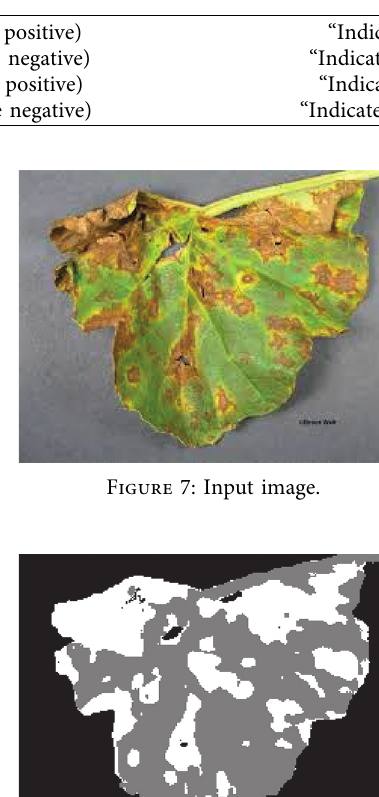
Table 7: Evaluation parameters.